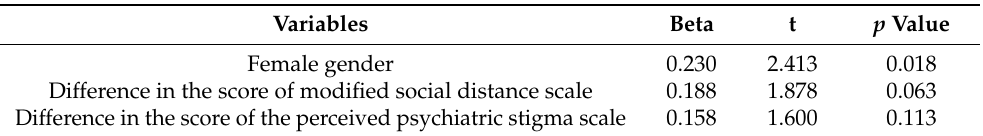
Table 3. Multiple regression analysis with the difference in the score of the modified attribution questionnaire as the dependent variable. Variables Beta Difference in the score of modified social distance scale 0.188 Difference in the score of the perceived psychiatric stigma scale 0.158 1.600 0.113